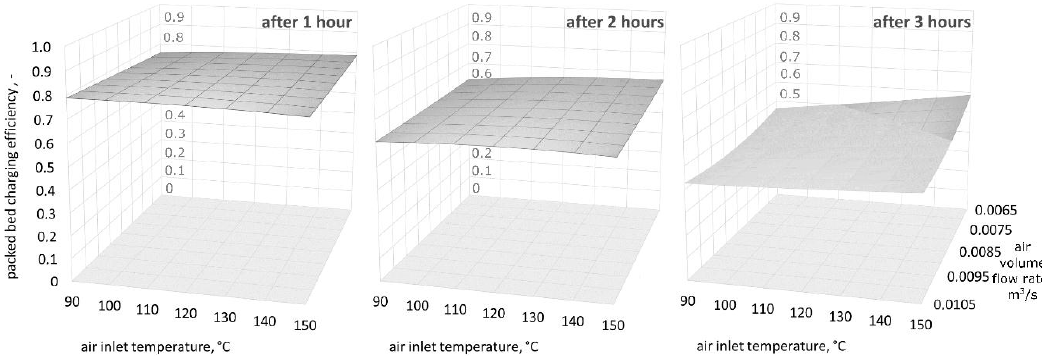
Figure 10. Relationship between the air inlet temperature, the air volume flow rate, and the theoretical efficiency of the packed bed charging process, for a granite sphere diameter equal to 70 mm, after one, two, and three hours of the charging process.